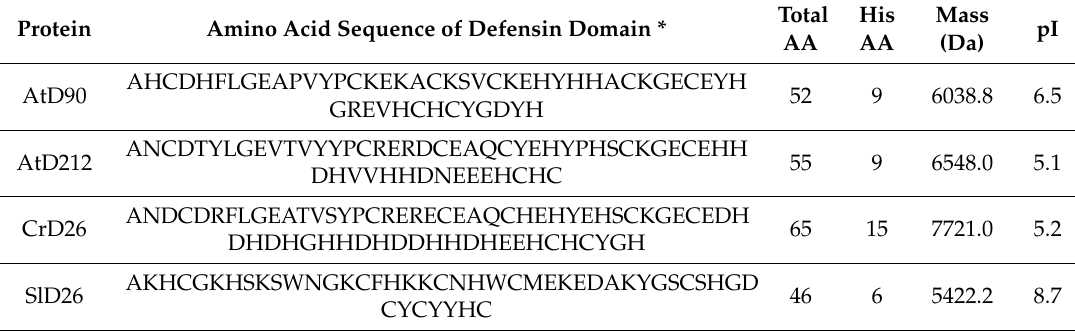
Table 1. Sequence and properties of HRDs as expressed and purified.